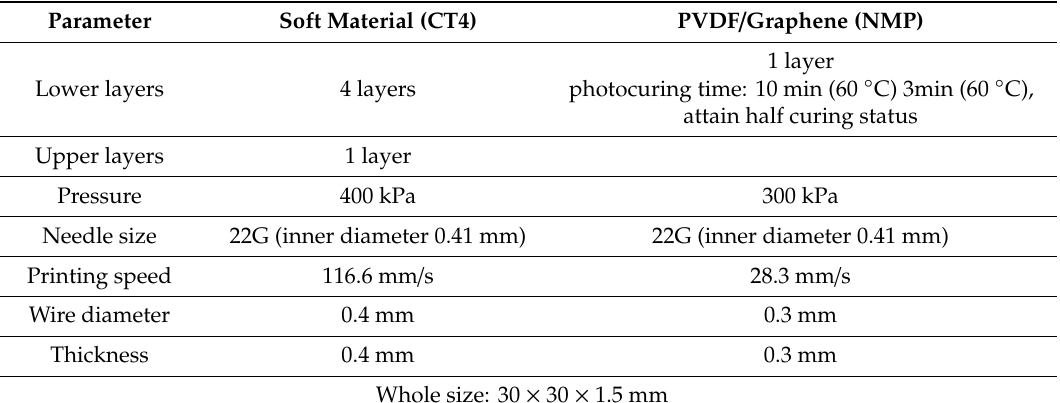
Table 3. Parameters of piezoelectric sensing pad.